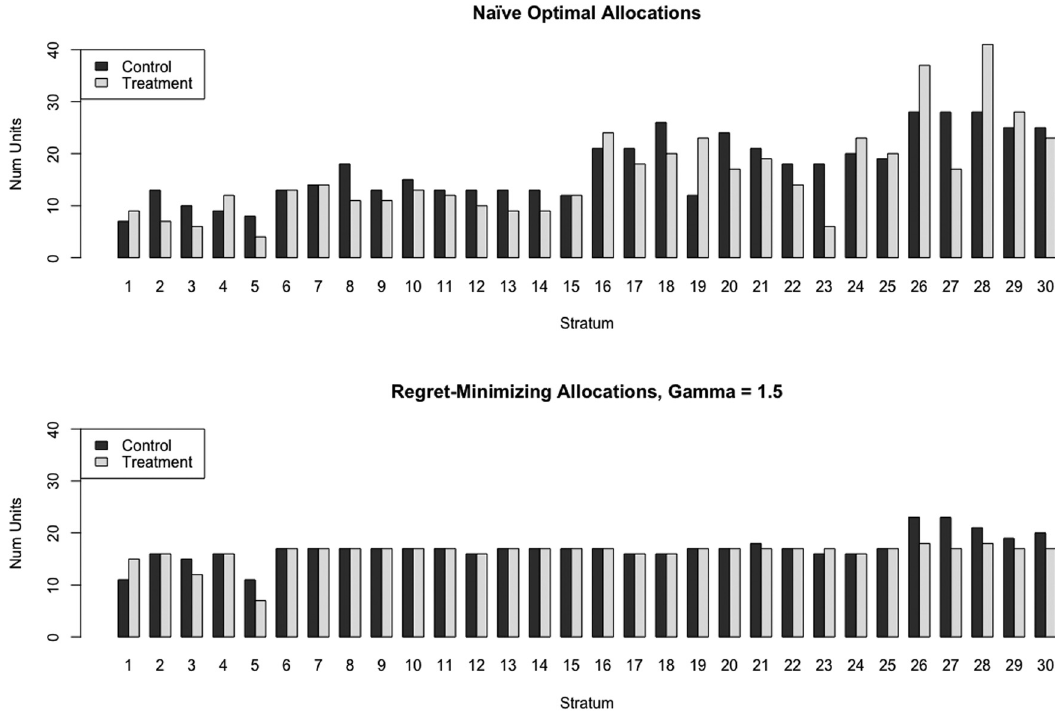
Figure 2: Allocation of units to strata under naïve allocation and regret - minimizing